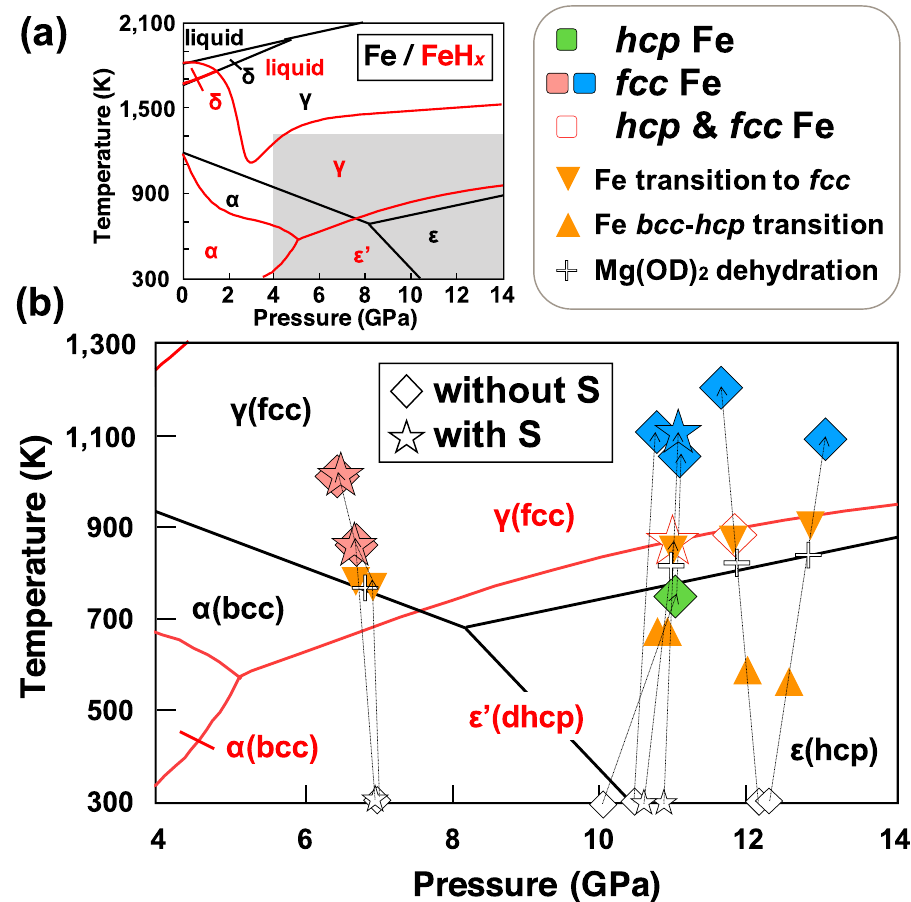
Figure 1. ( a ) Phase diagrams of iron and FeH x . Phase boundaries of FeH x and Fe are from previous studies (Antonov et al. 30 ; Fukai et al. 31 ; Klotz et al. 32 ). ( b ) An enlarged region of the gray area in ( a ) with PT paths of the neutron diffraction experiments. All data are hydrous samples with/without sulfur denoted as stars and diamonds, respectively. Larger symbols show the long-duration measurements. The occurrence of phase transitions of Fe is shown as triangles (filled triangle for transition to fcc from bcc or hcp ; filled inverted triangle for bcc - hcp transition). The dehydration of Mg(OD) 2 is denoted as “+”